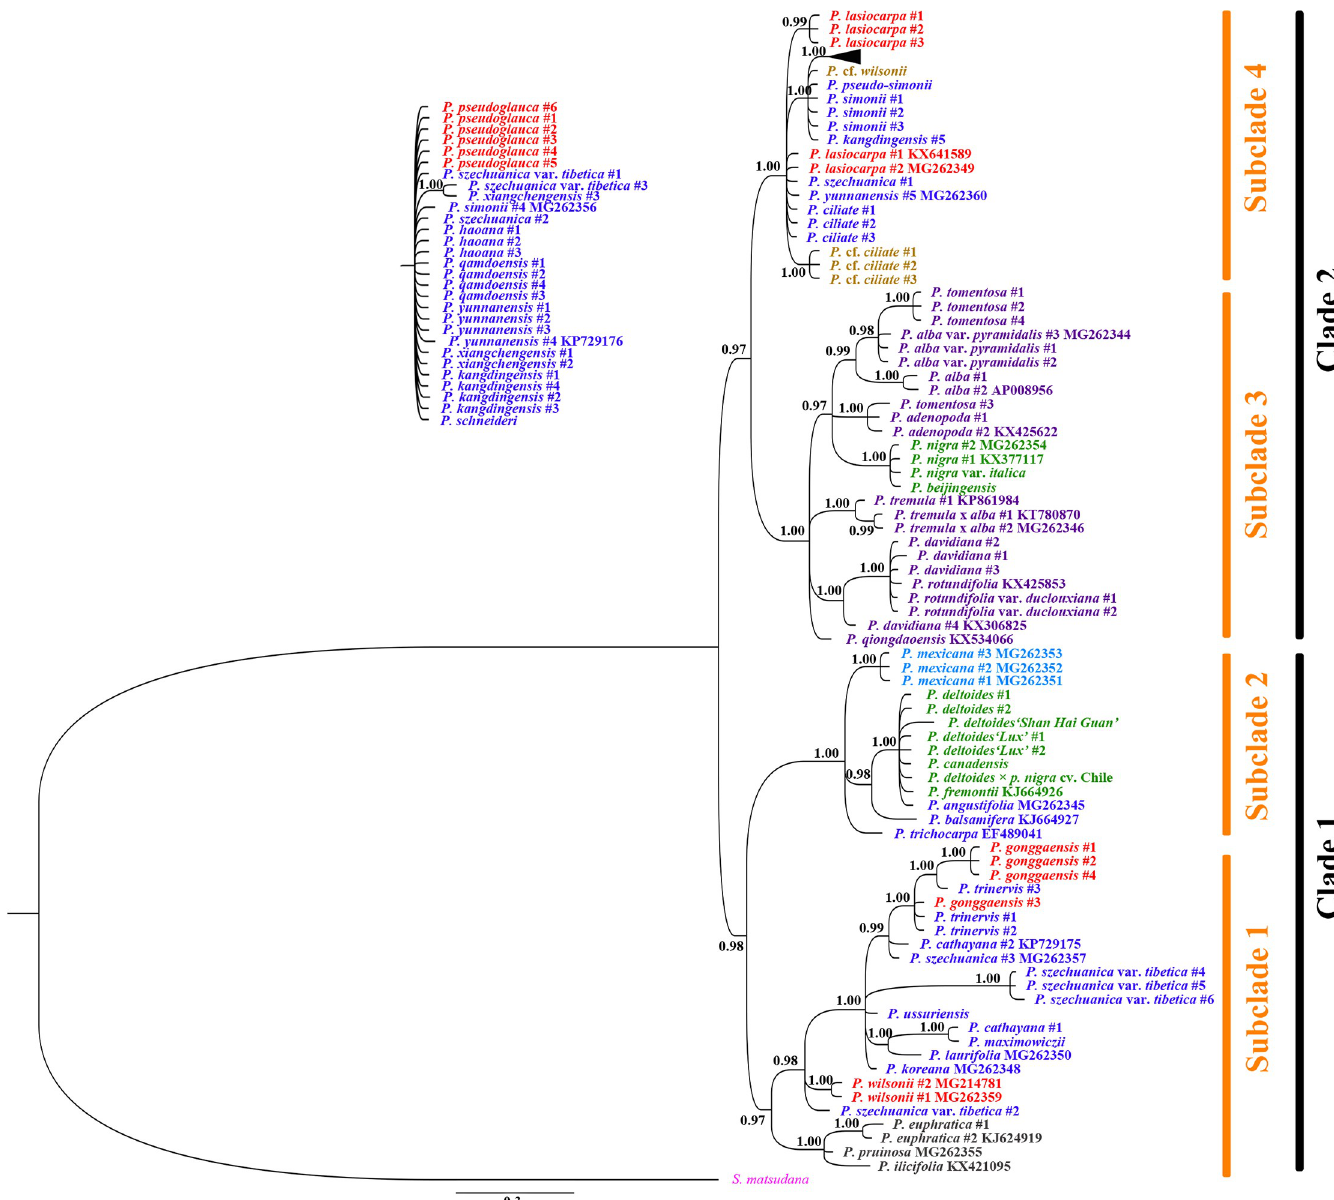
Fig 4. Bayes phylogenetic tree based on the combined data from all eight chloroplast regions. The K81uf+I+G model for appropriate nucleotide substitution was constructed using Modeltest 3.7 with the AIC. Bayesian posterior probability values are reported for nodes over 50%. The traditional species taxa, based on morphological characteristics, are shown in different colors. The outgroup is pink, Tacamahaca is blue, Aigeiros is green, Leuce is purple, Leucoides is red, Turanga is brown, Abaso is skyblue, and hybrids are yellow.